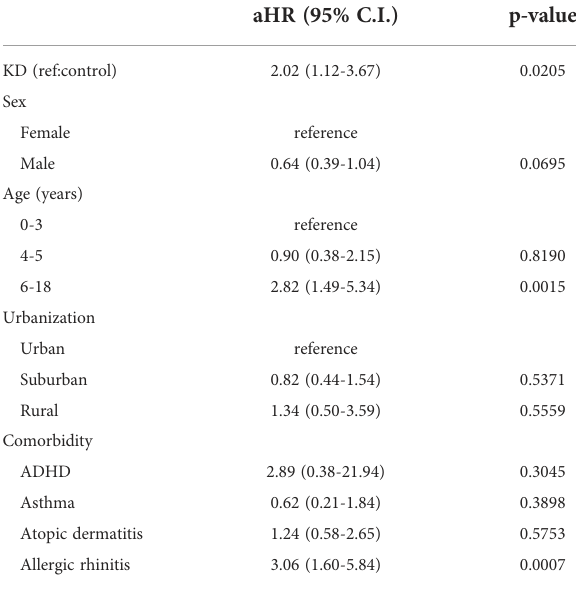
TABLE 3 Hazard ratios for JIA in the multiple Cox